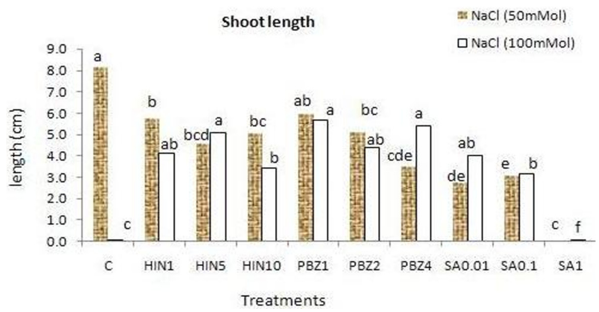
Fig. 2. Effect of hinokitiol, salicylic scid and paclobutrazol on shoot length